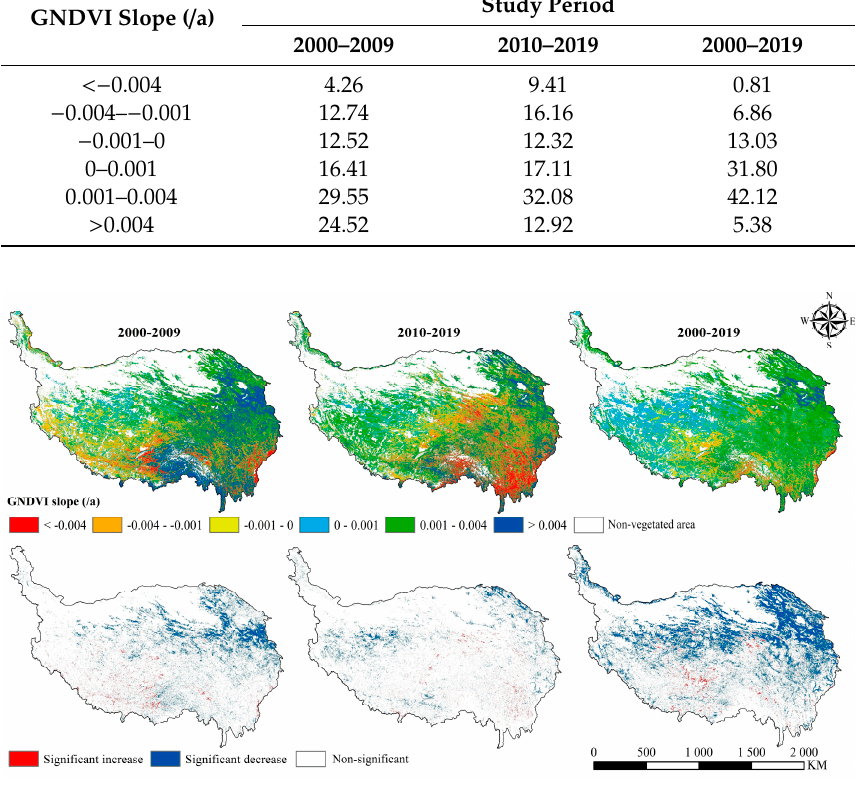
Figure 4. The spatial patterns of the GNDVI trend on the QTP. The figures above show the GNDVI slope in different periods, and the figures below show the corresponding significance of the GNDVI